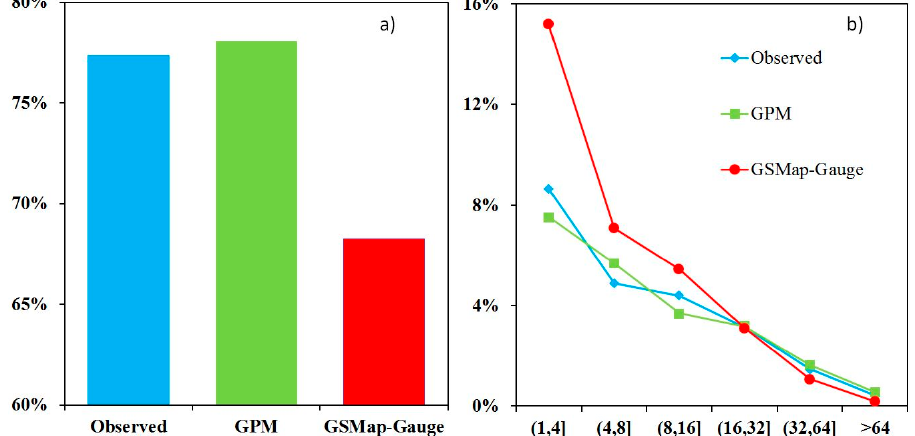
Figure 7. ( a ) The frequency distribution of daily precipitation by occurrence for no rain and light rain